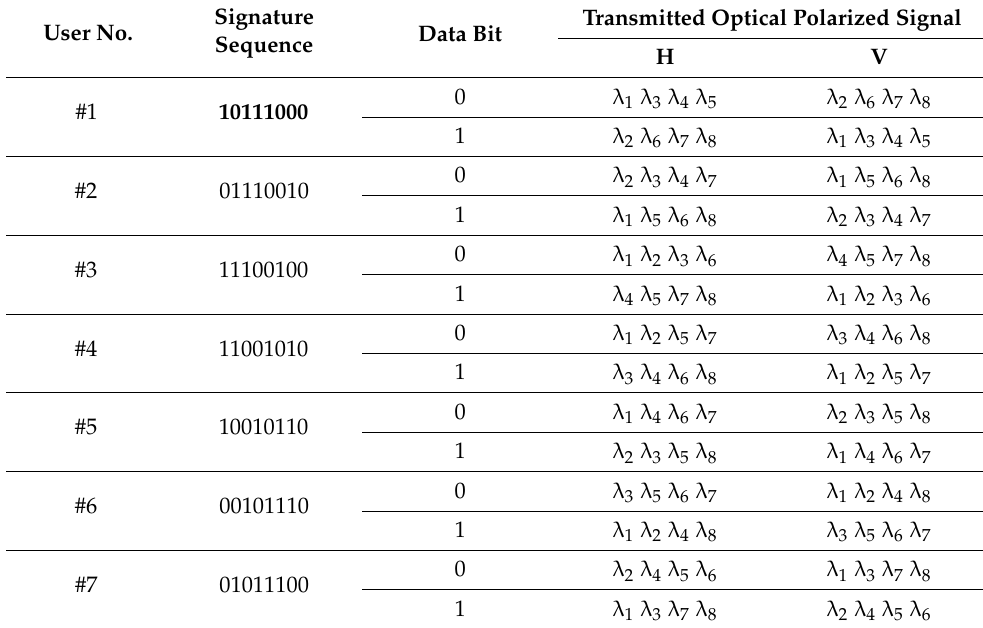
Table 1. Modified M-sequence codes of length 8 with spectral-polarization coding. User